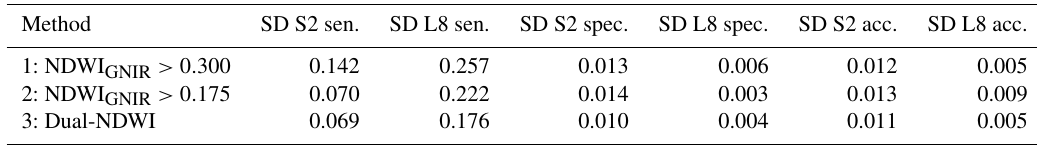
Table A2. Standard deviation (SD) of the values for sensitivity (sen.), specificity (spec.) and accuracy (acc.) across three test sites: Amery, George VI and Bach ice shelves for S2 and L8